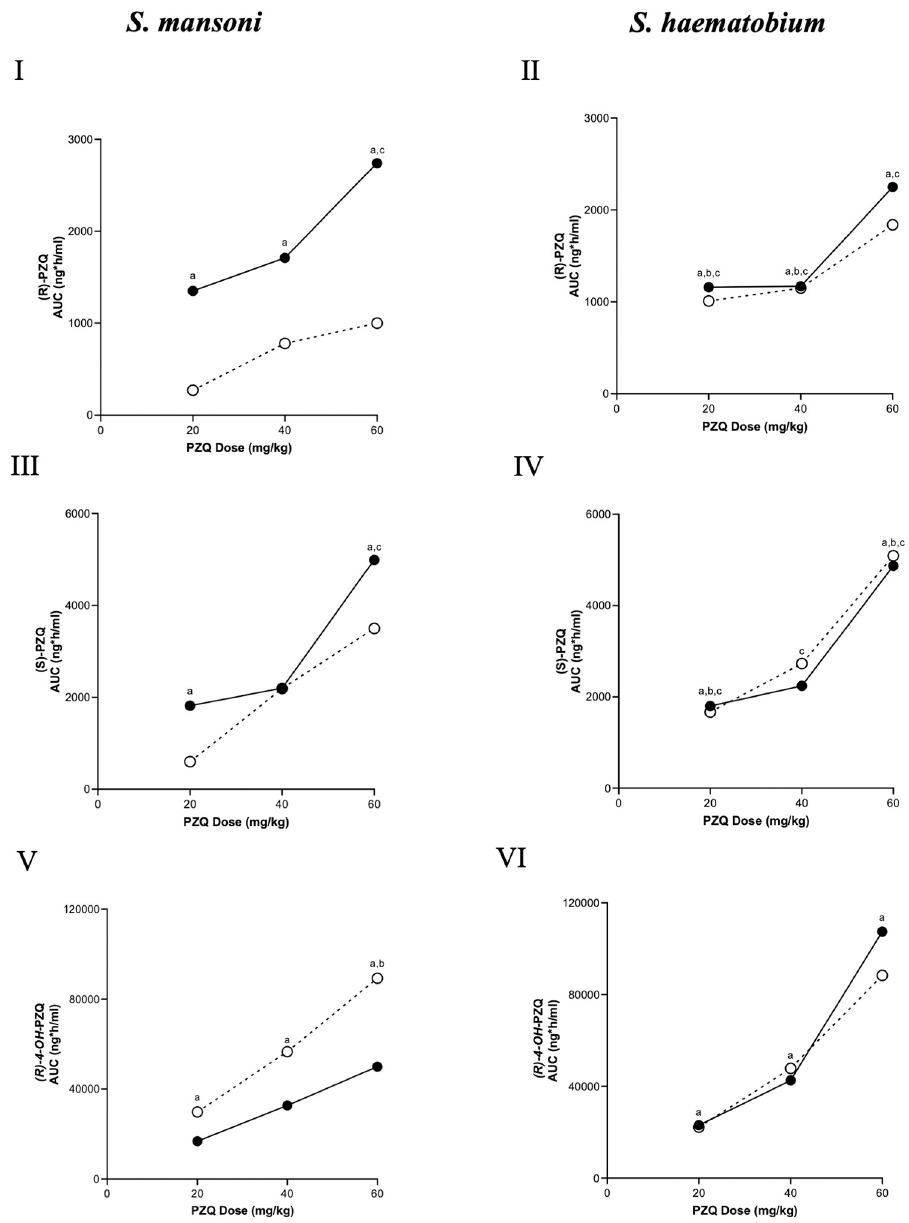
Fig 4. The mean AUC values extracted from the included studies against PZQ dose of (R)-PZQ [I, II], (S)-PZQ [III, IV], and the major metabolite (R)-trans-4-OH-PZQ [V, VI] at 20, 40, and 60 mg/kg. The data are extracted from Kovac and colleagues [56], which investigated S . mansoni and S . haematobium infected PSAC ( ● ) and SAC ( � ) treated with PZQ. The AUC values were then plotted against the dose of PZQ administered for further analysis. P < 0.05 was considered statistically significant; a: significant difference between SAC and PSAC for the same dose and analyte, b: significant difference between S . haematobium and S . mansoni for the same dose, age group, and analyte, and c: significant difference between (R)-PZQ and (S)-PZQ for the same dose, age group, and species. AUC, area under the curve; PSAC, preschool-aged children; PZQ, praziquantel; SAC, school-aged children.